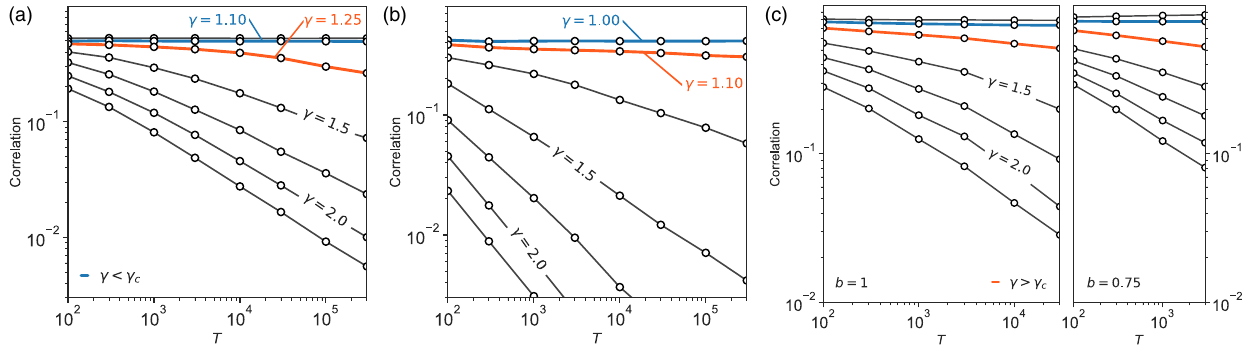
FIG. 4. Finite-size scaling analysis for the results of Fig. 3. The average correlation attained by OD is shown against the size T of networks generated using (a) b ¼ 1 and (b) b ¼ 0 . 75 , for γ ∈ f 1 . 00 ; 1 . 10 ; 1 . 25 ; 1 . 50 ; 1 . 75 ; 2 . 00 ; 2 . 25 g (from top to bottom). Two scaling curves are highlighted and annotated in each figure: the curve associated with the largest value of γ that does not decline with T (blue), and the first curve that varies with T after that (orange). (c) Scaling of the symmetry bound for the same values of γ in the case of trees (left) and dense graphs (right). The scaling is not computed for large values of T due to computational costs. Note that there are many known structural transitions between the highlighted curves [41], which are not shown for the sake of transitions in the case of trees, at γ m ¼ ð m þ 1 Þ =m for m ¼